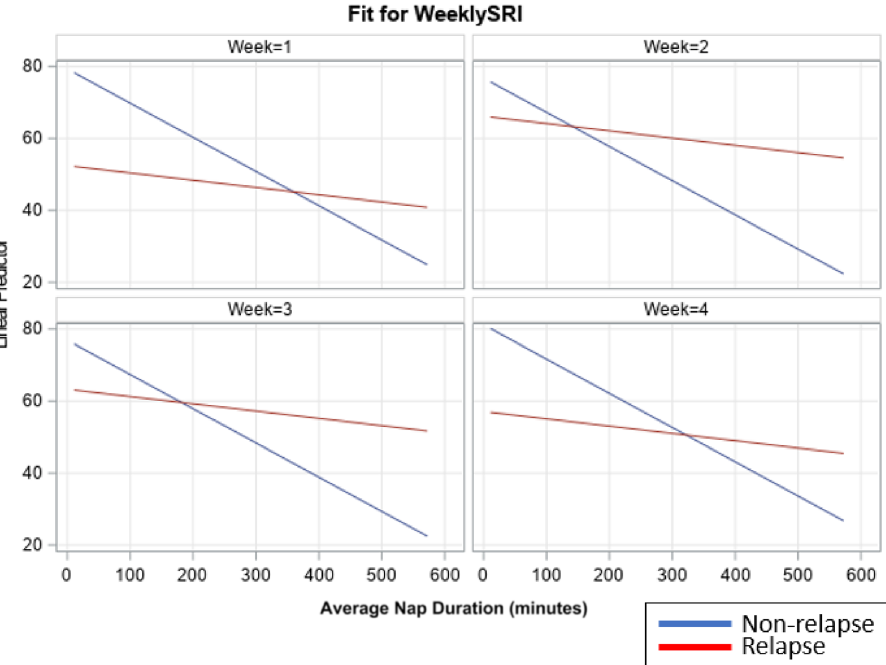
Figure 4. Weekly SRI versus Weekly Nap Duration between relapse and non-relapse. Weekly SRI and mean nap duration in individuals who relapsed (red) and those no did not (blue). The y-axis indicates the model predicted weekly SRI and the x-axis indicates the average nap duration over the group. The slope of the non-relapsed group is steeper indicating that napping had a higher impact on the SRI in individuals who did not